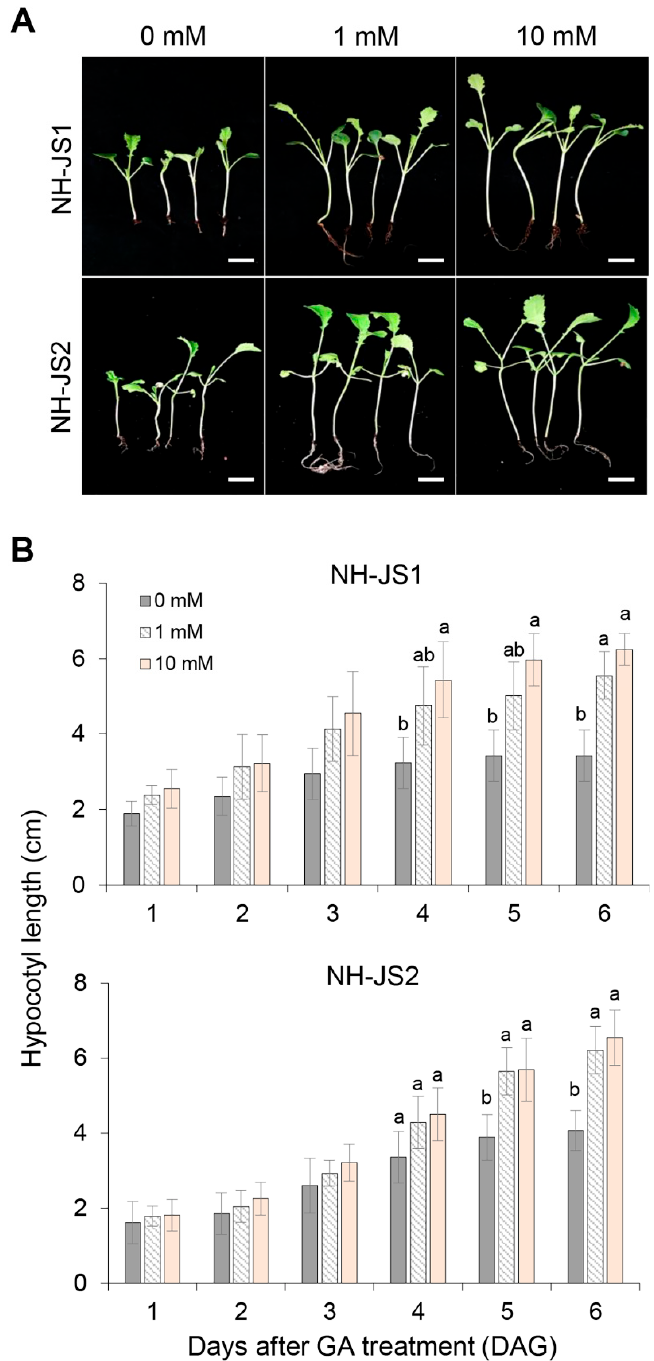
Figure 2. Hypocotyl phenotypes of the two inbred radish lines after GA treatment. ( A ) Hypocotyl phenotypes of the two radish lines after GA (0, 1, or 10 mM) treatment. Seeds were grown in a dark cold room at 5 ± 1 °C for 3 days and then transferred into a 25 °C growth room. Radish sprouts with hypocotyls longer than 0.5 cm were selected, and GA solution was poured directly over the seedlings ( n = 6). Hypocotyl phenotypes were observed at 6 days after GA treatment. Scale bars = 0.5 cm. ( B ) Average hypocotyl lengths of NH-JS1 and NH-JS2. Bars represent the average hypocotyl lengths at different GA concentrations. Data are presented as mean ± SD ( n = 6, except for 3–4 maximum and minimum seedlings). Asterisks mark significant differences between GA treatment compared with the absence of exogenous GA (one-way ANOVA followed by Bonferroni post hoc test).